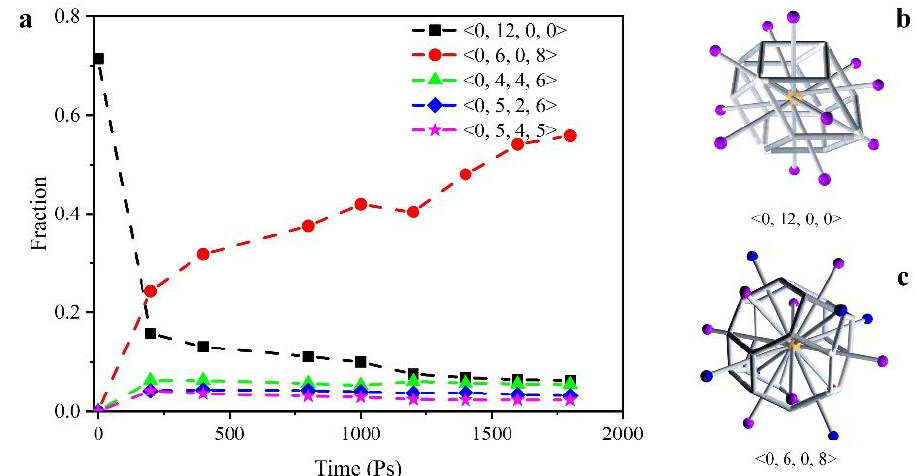
Figure 6. The change of Voronoi polyhedron with the increase of deposited atoms. ( a ) <0,12,0,0>, <0,6,0,8>, <0,4,4,6>, <0,5,2,6> and <0,5,4,5> fractions with the deposit time; ( b ) the structure of <0,12,0,0> Voronoi cell; ( c ) the structure of <0,6,0,8> Voronoi cell. (For structural clarity, the central atom is indicated in yellow and the other atoms in purple or blue). To demonstrate the amorphous structure of the films from macroscopic statistics of the atomic arrangement. We use RDF to describe the atomic distribution inside the film after different deposition times. Combined with the distribution of Voronoi cells at the analyzed. Figure 7d shows the atomic distribution at 1800 Ps deposition. The smaller prob- ability of finding a Cu atom at the same distance through the RDF of the Cu-Cu pair cor- responds to the smallest proportion of Voronoi cells centered on Cu atoms. g(r) fluctua- tions between Cu-Ta and Ta-Ta are smaller and the amorphous character is more pro- nounced.